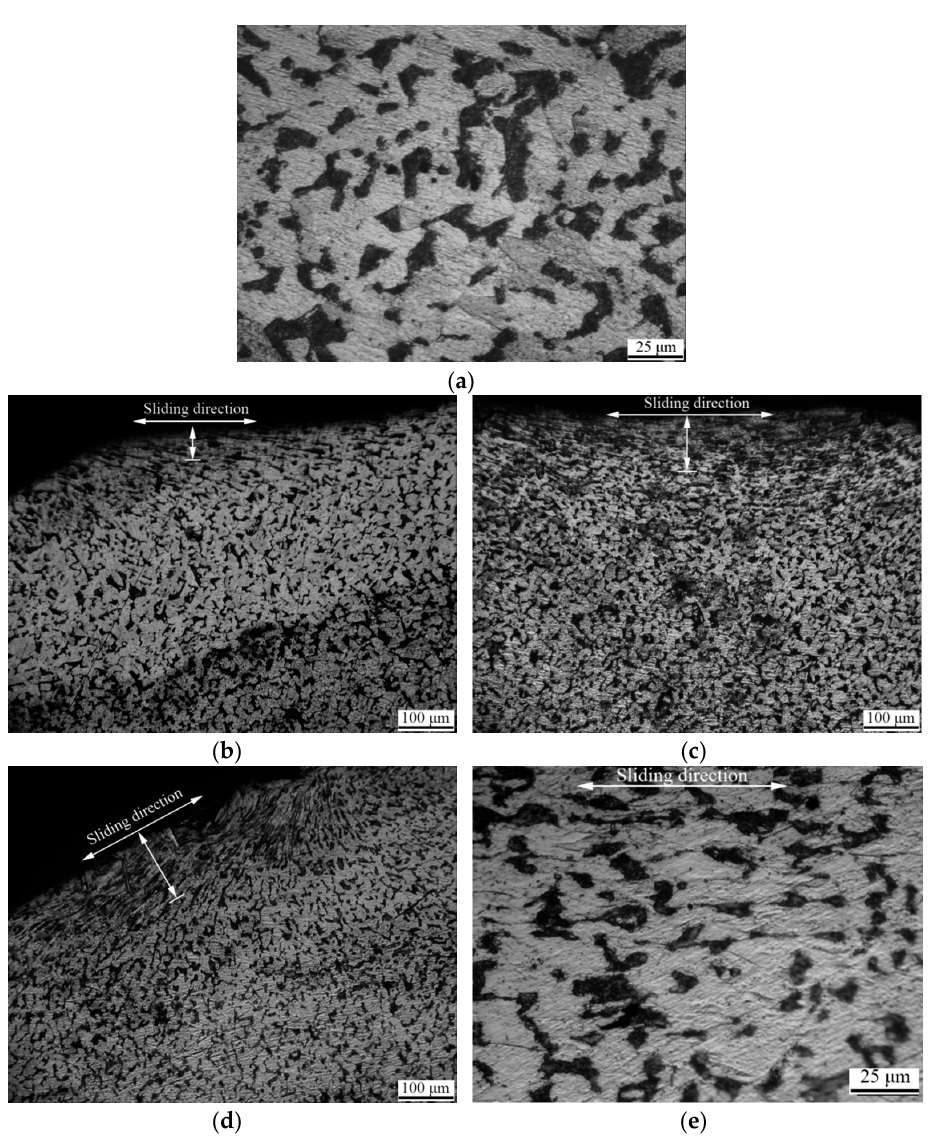
Figure 5. Wear edge metallographic structure under different wear loads, ( a ) the original sample; ( b ) wear load 4000 N; ( c ) wear load 6000 N; ( d ) wear load 8000 N; ( e ) enlarged view of wear load 8000 N.